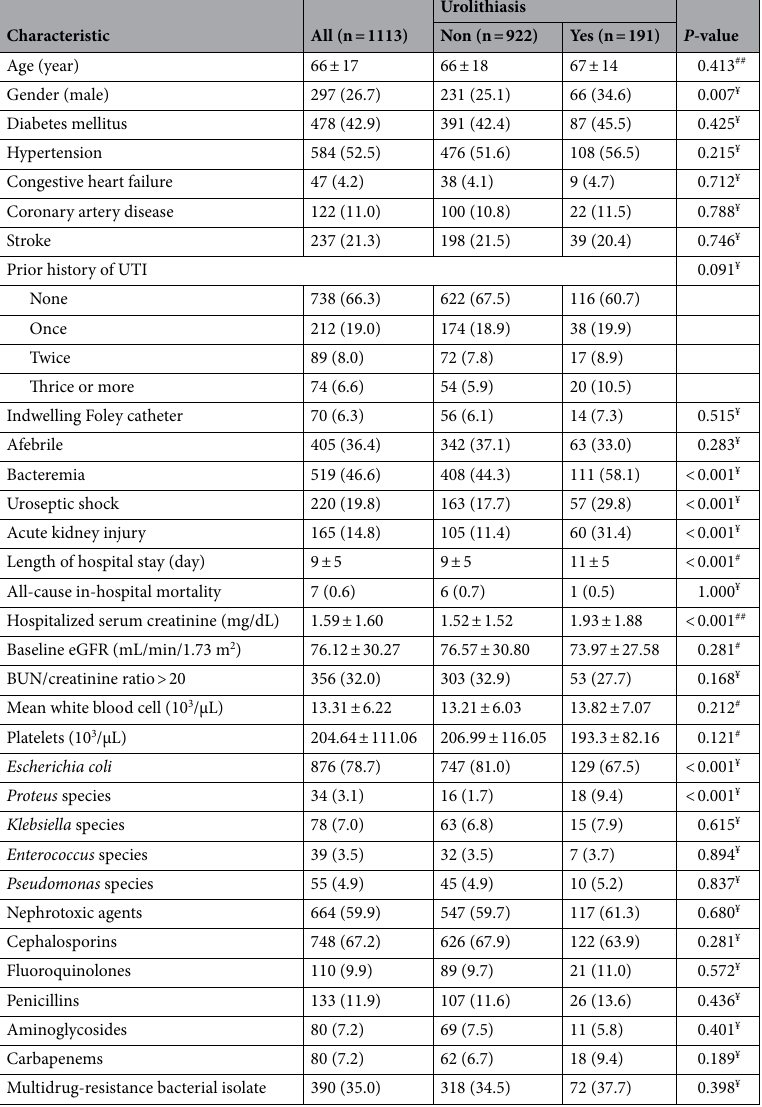
Table 1. Characteristics of hospitalized patients with urinary tract infection with respect to urolithiasis. UTI urinary tract infection, eGFR estimated glomerular filtration rate, BUN blood urea nitrogen. # Student T-test. ## Mann–Whitney U -test. ¥ Chi-Square test or Fisher’s exact